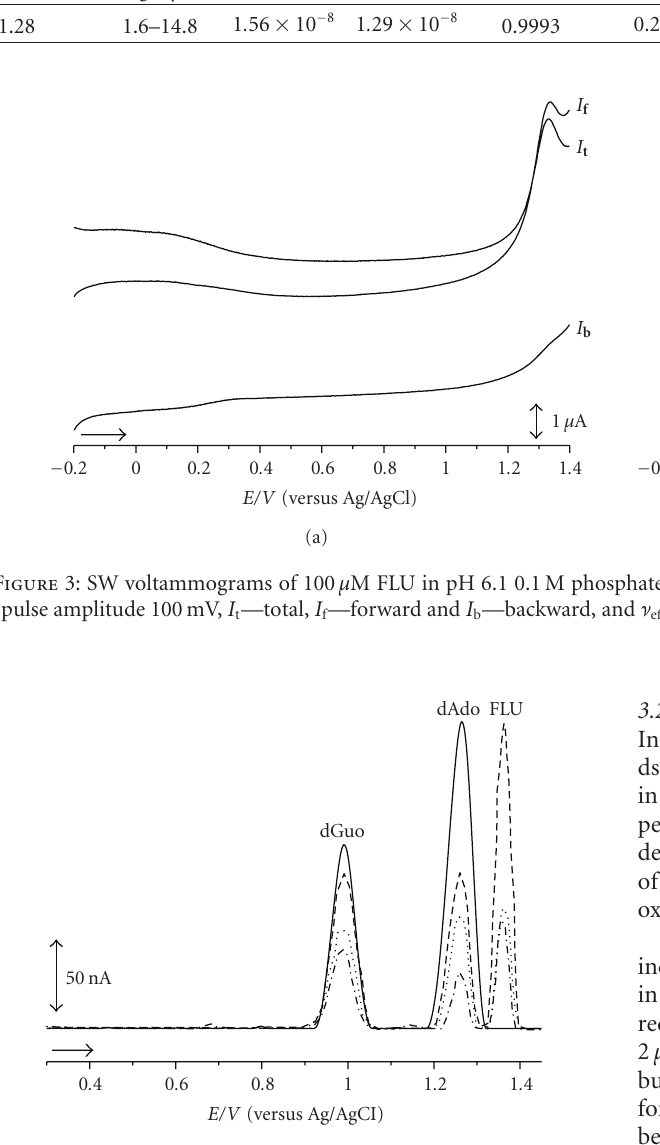
Figure 4: DP voltammograms baseline corrected in pH 4.5 0.1 M acetate bu ff er of: (solid line) 100 μ gmL − 1 dsDNA and incubated solutions during (dashed line) 0 h, (dotted line) 1h, and (dash- dotted line) 3h of 100 μ gmL − 1 DNA with 2 μ M FLU. Pulse amplitude-50mV, pulse width-70ms, and ν = 5mVs − 1